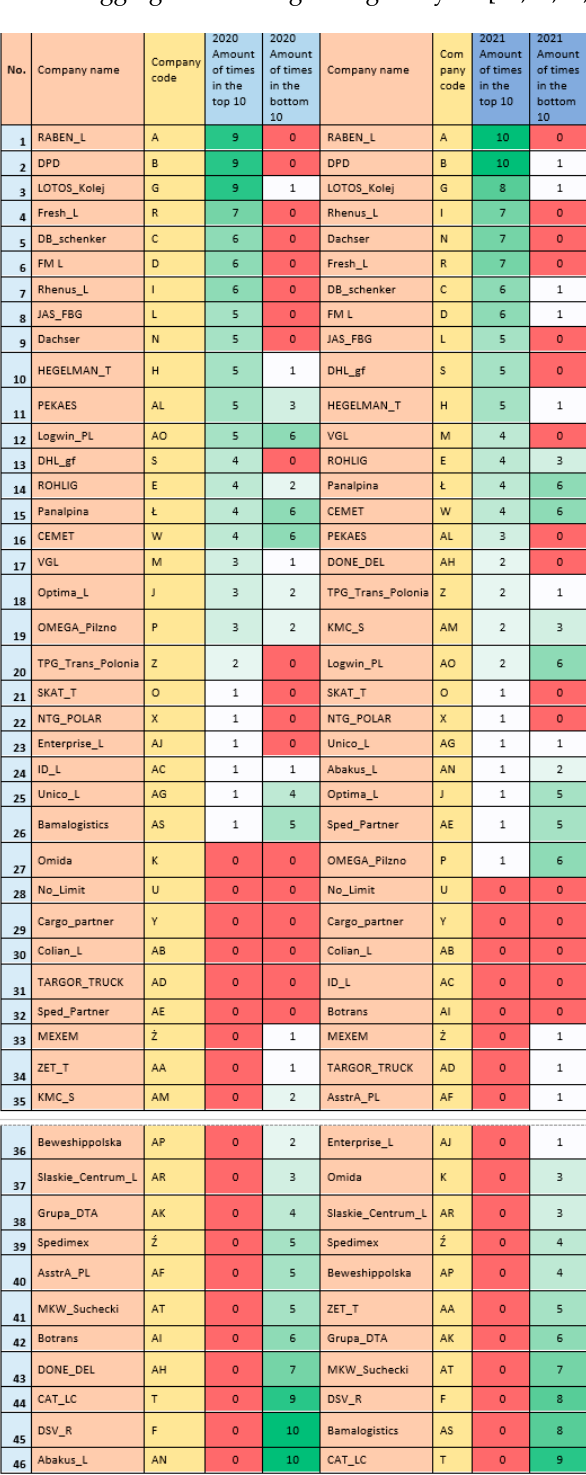
Scheme 4. Aggregated ranking of 46 LSP companies based on signaturization. Based on own re- search.